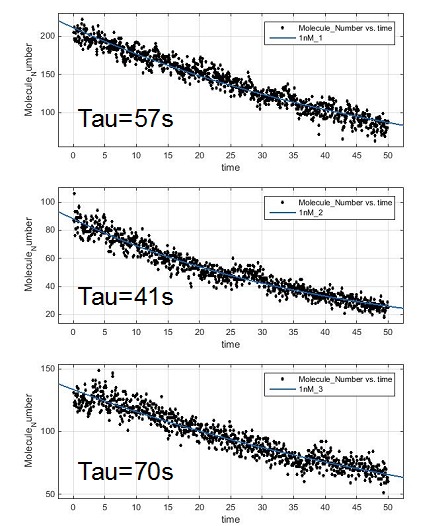
Measurement of the photobleaching time of SA-atto647N.At 1 nM of SA-atto647N, the average photobleaching time is about 61 s. Thus, we were able to measure the diffusion coefficient of AMPA receptors using SA-atto647N.